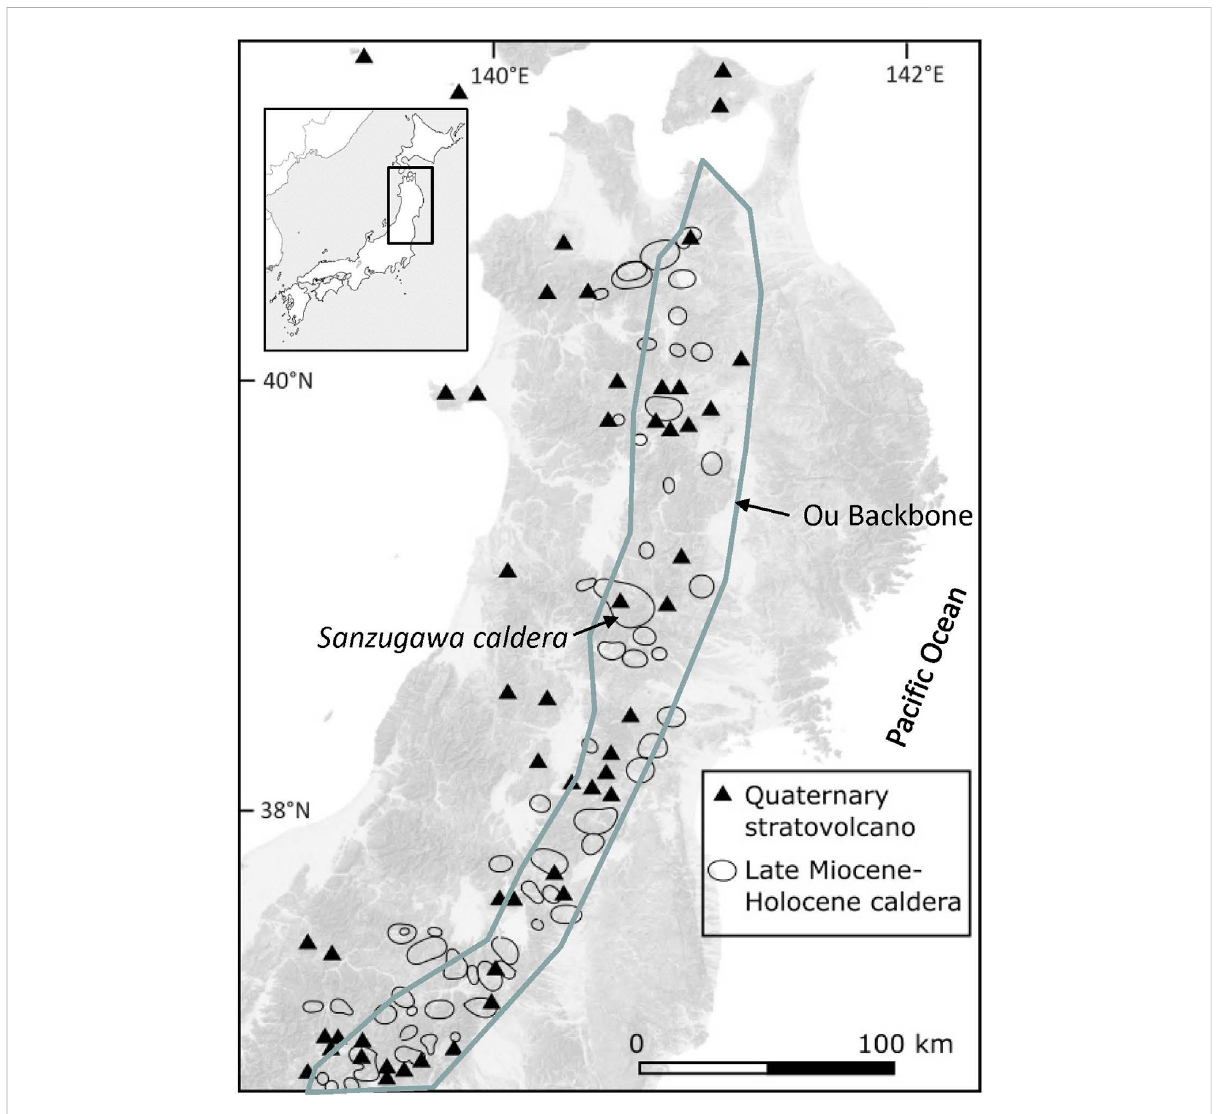
FIGURE 1 DistributionofthelateMiocenetoQuaternaryvolcanoesintheTohokuregionmodi fi edfromYamamoto(2009).Mostvolcanoesaresituatedin the Ou Backbone, an uplifted area of the central mountainous range. Inset map shows Japan and its corresponding area.